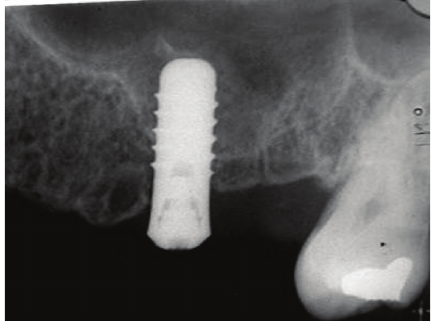
Figure 1: Baseline orthopantomogram showing that the subantral boneheightwaslimitedatthemaxillaryposteriorleftquadrant,with severelyresorbedalveolarboneheightatthesiteofthefirstmaxillary molar.